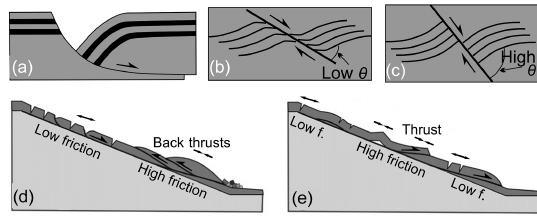
Figure 9. (a) Bending of strata due to adaptation along a listric nor- mal fault (rollover anticline); (b) normal fault with normal bending of layers, coherent with the sense of shear; (c) normal fault with reverse (apparent) sense of shear due to a high angle (cid:50) ( b and c re- drawn after Grasemann et al., 2005); (d) development of low-angle back thrusts at the toe of a DSGSD; (e) development of low-angle back thrusts and other contractional deformations in different parts of a DSGSD due to spatial changing in friction ( d and e modified after Braathen et al.,